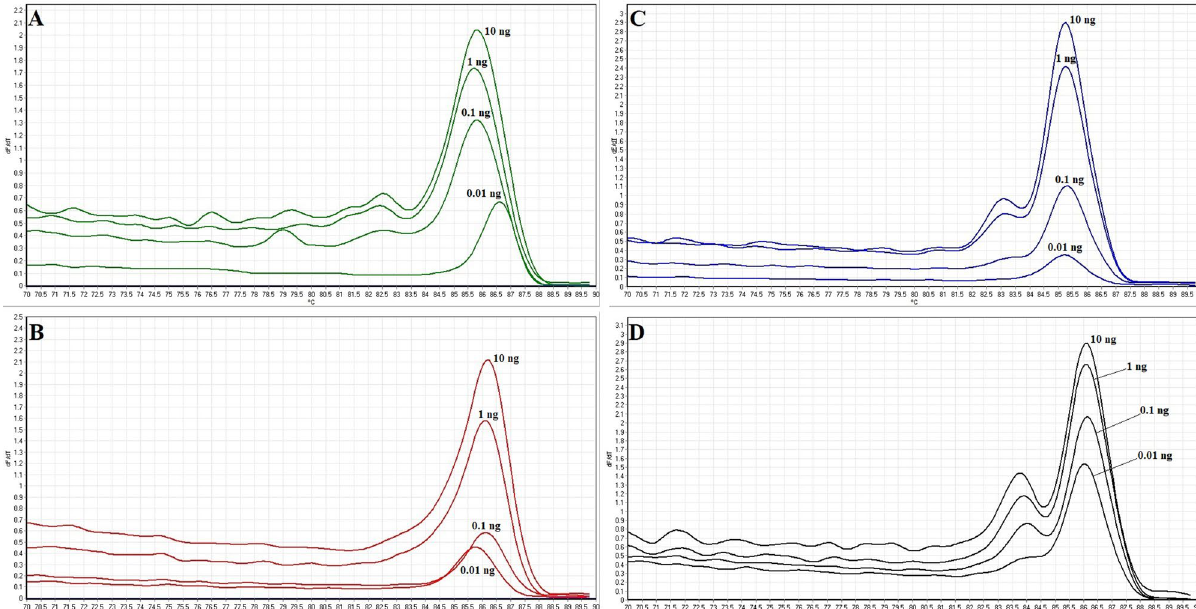
Figure 5. Melting curves of DNA tenfold dilution series for ( A ) S. dysenteriae , ( B ) S. flexneri , ( C ) S. boydii and ( D ) S. sonnei